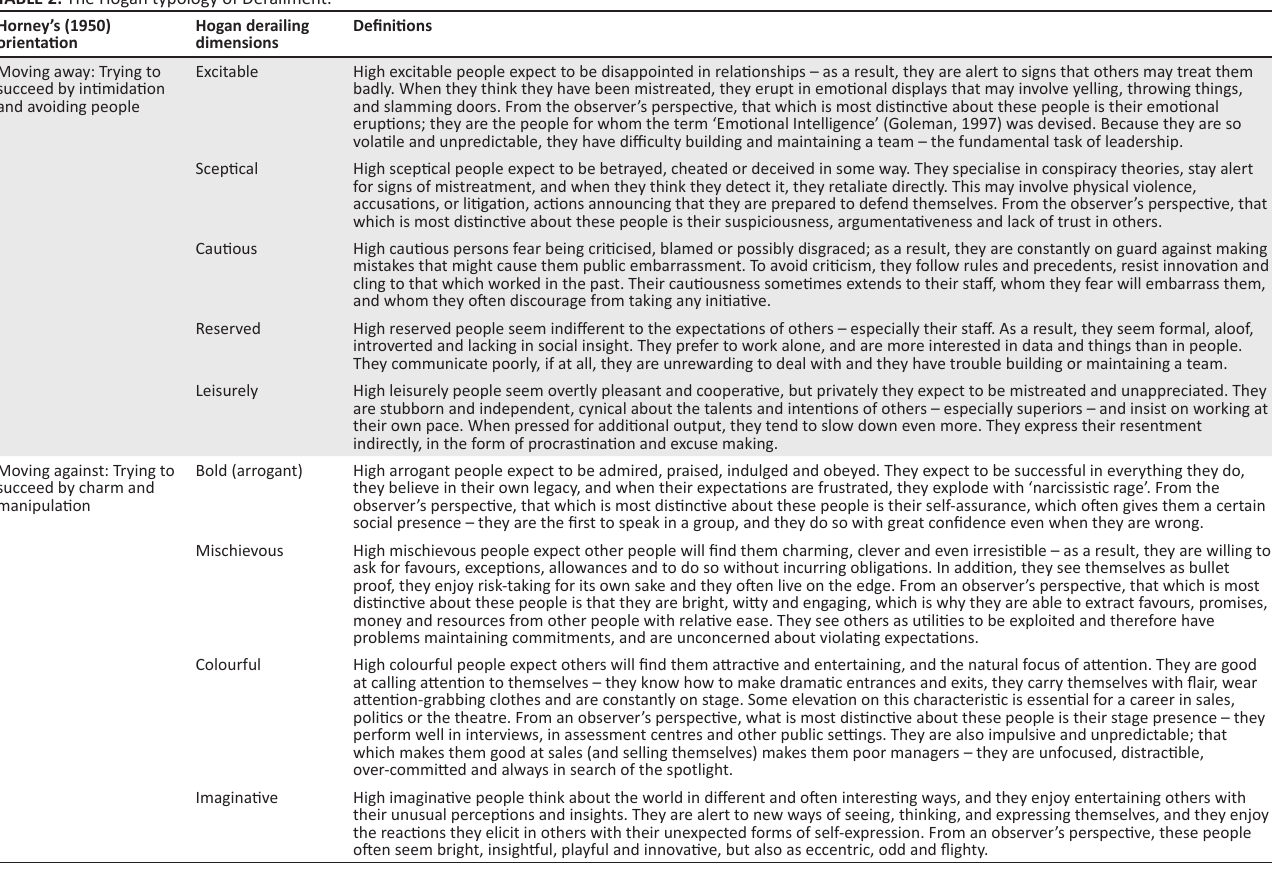
TABLE 2: The Hogan typology of Derailment. Horney’s (1950)